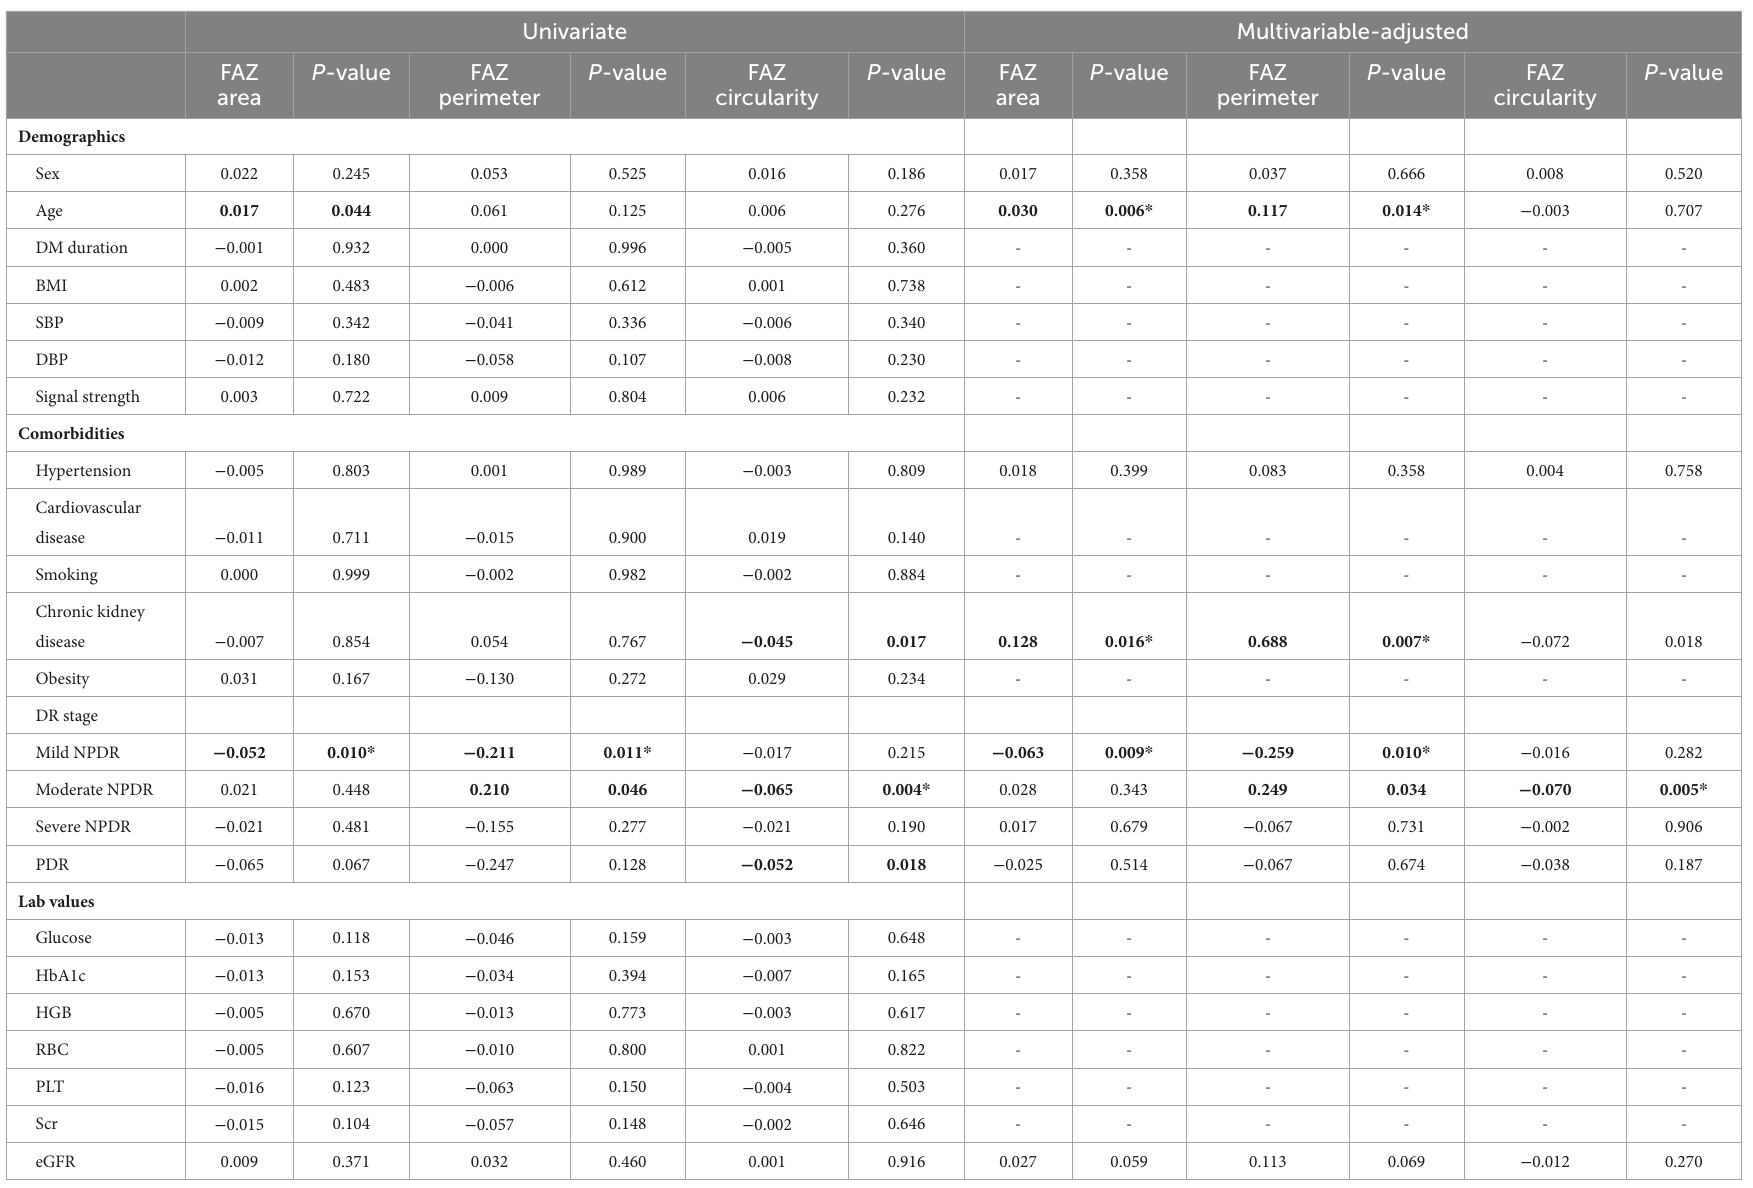
TABLE 5 Association of systemic factors with FAZ parameters in OCTA 6 × 6-mm